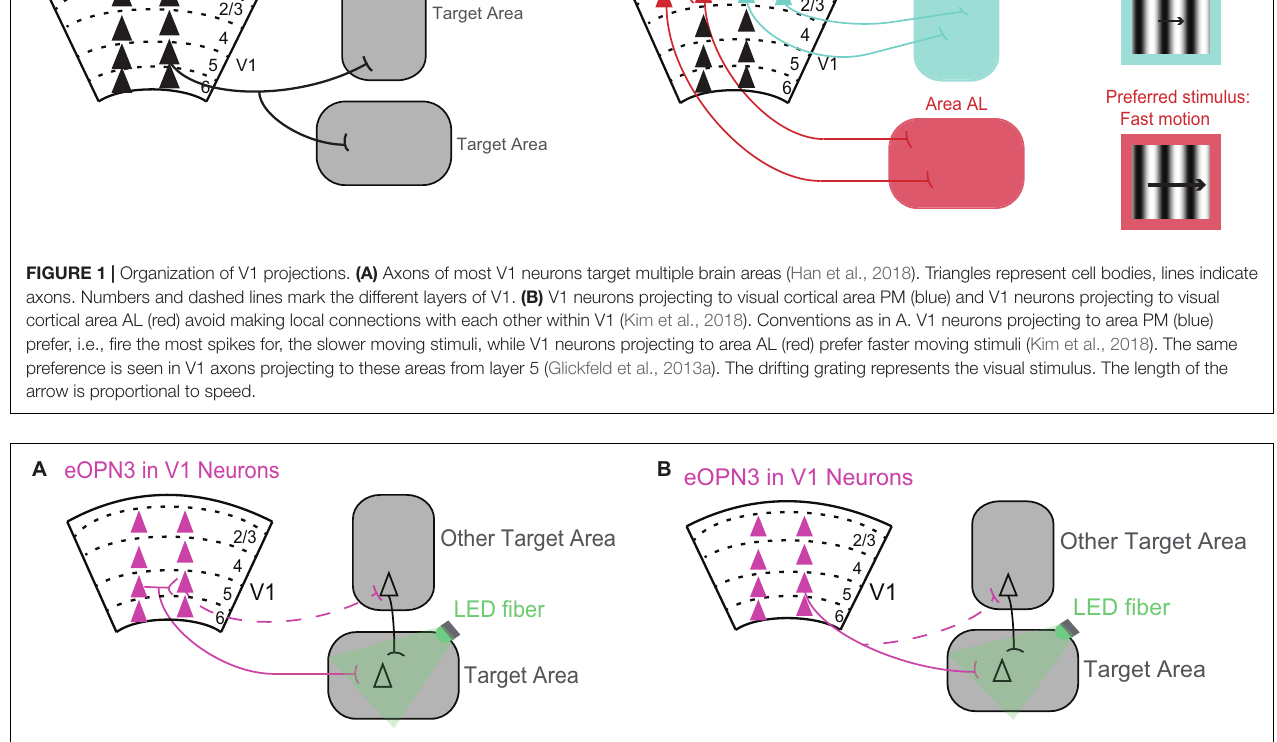
FIGURE 2 | Using inhibition of neurotransmitter release from axonal terminals to dissect the circuits through which V1 mediates its effects in the target area. (A) A V1 projection can mediate its effects in the target area either directly via its projection to the target area (solid line) or indirectly via its local connections with other V1 projections (dashed line). Triangles represent cell bodies, lines indicate axons. Scarlet indicates expression of eOPN3 in V1 neurons. eOPN3 is a mosquito derived rhodopsin that inhibits neurotransmitter release when axon terminals are illuminated with light (here, green LED fiber; Mahn et al., 2021). For a similar rhodopsin see Copits et al. (2021). (B) A V1 projection can mediate its effects in the target area either directly via its axonal branch to the target area (solid line) or indirectly through another axonal branch targeting another area (dashed line). Conventions as in (A)